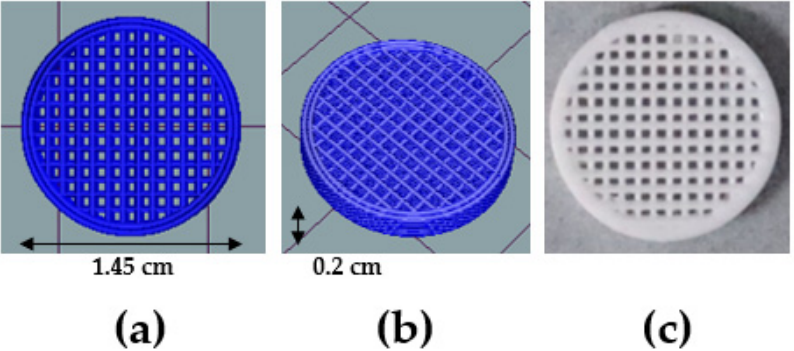
Figure 1. 3D-printed PLA scaffold filter—( a , b ) 3D design of the filter, ( c ) printed scaffold filter im- age.